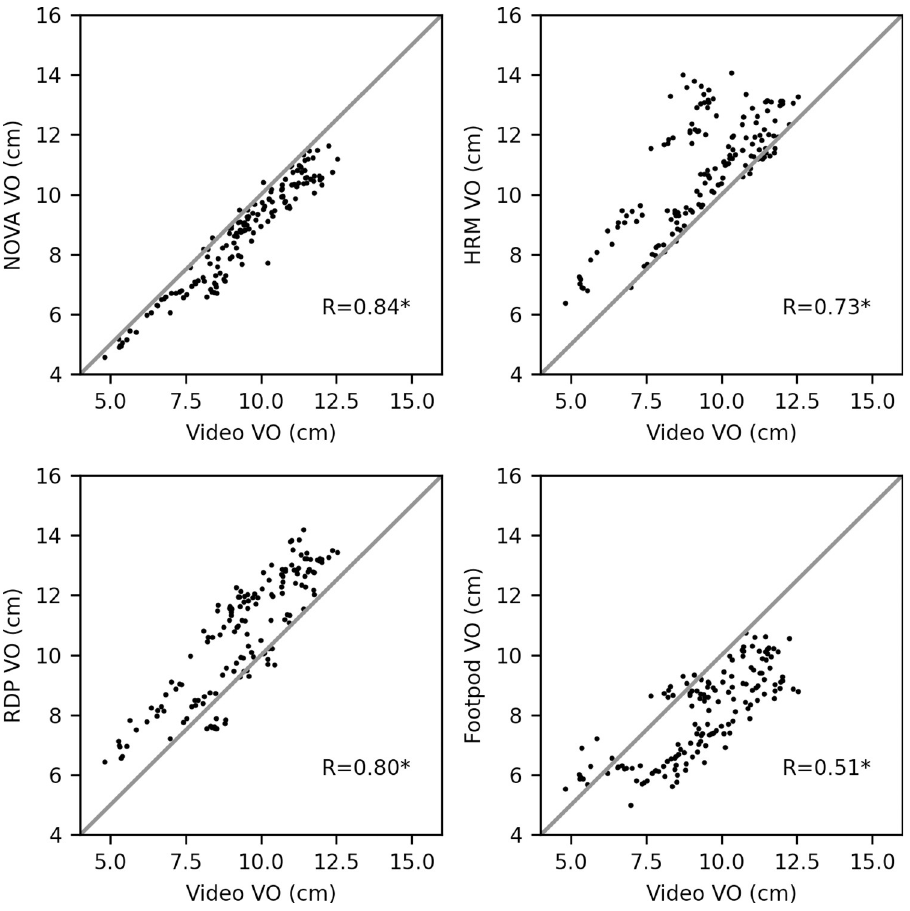
Fig 5. Video analysis vertical oscillation versus wearable devices. Scatter plots of the video analysis vertical oscillation measurements (VO) versus VO values from four wearable devices; the INCUS NOVA (top left), Garmin HRM-Pro chest strap (top right), Garmin Running Dynamics Pod positioned on the waistband (bottom left), and the Stryd Running Power Meter Footpod (bottom right). All running intervals (n = 10) and participants (n = 15) are included. The diagonal line represents the line of unity for the video analysis measurements. Repeated measures correlation R values between the video analysis and devices are shown ( � p < 0.05).